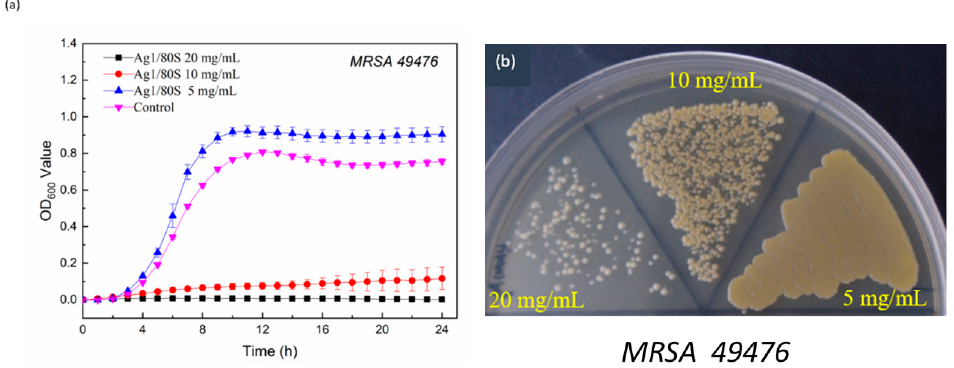
Figure 10. Microbiological assay of Ag1/80S against MRSA (ATCC 49476); ( a ) kinetics curves of microbial growth; and ( b ) colony-forming capacity assay.